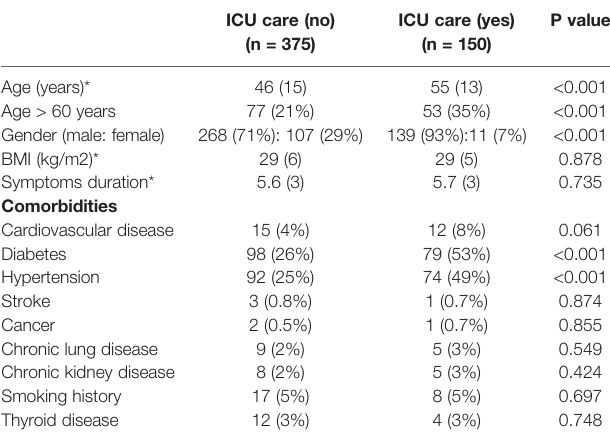
TABLE 8 | Age, gender, body mass index, symptoms duration and comorbidities of 150 symptomatic COVID-19 patients needed Intensive care unit (ICU) admission vs. 375 did not need ICU